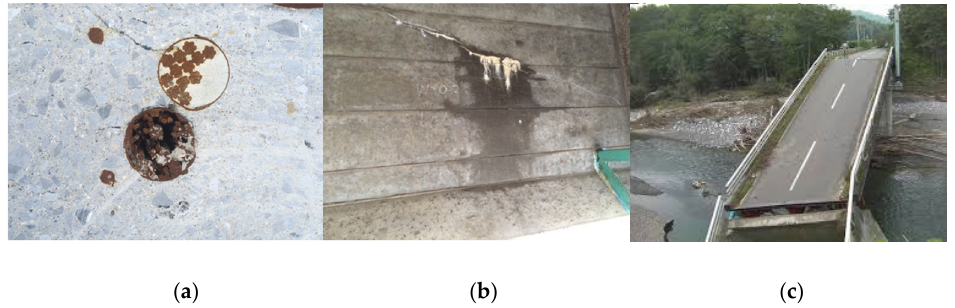
Figure 3. Degraded and collapsed bridges. ( a ) Cross section of PC sheaths ( b ) Concrete surface crack ( c ) collapse [4].